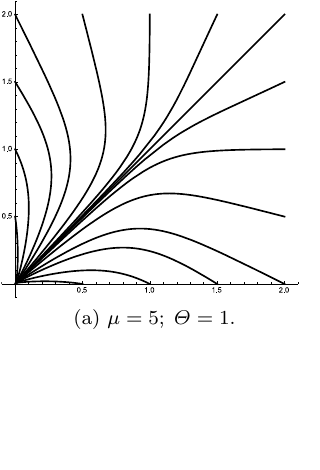
Figure 9. The phase portraits with different